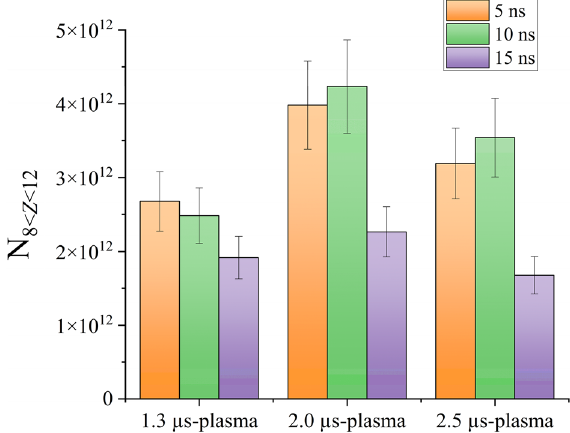
Figure 7. temporal evolutions of N 8≤Z≤12 at Central region of the three